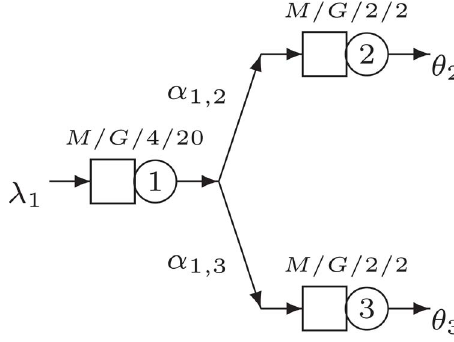
Figure 3. Basic split network B1.